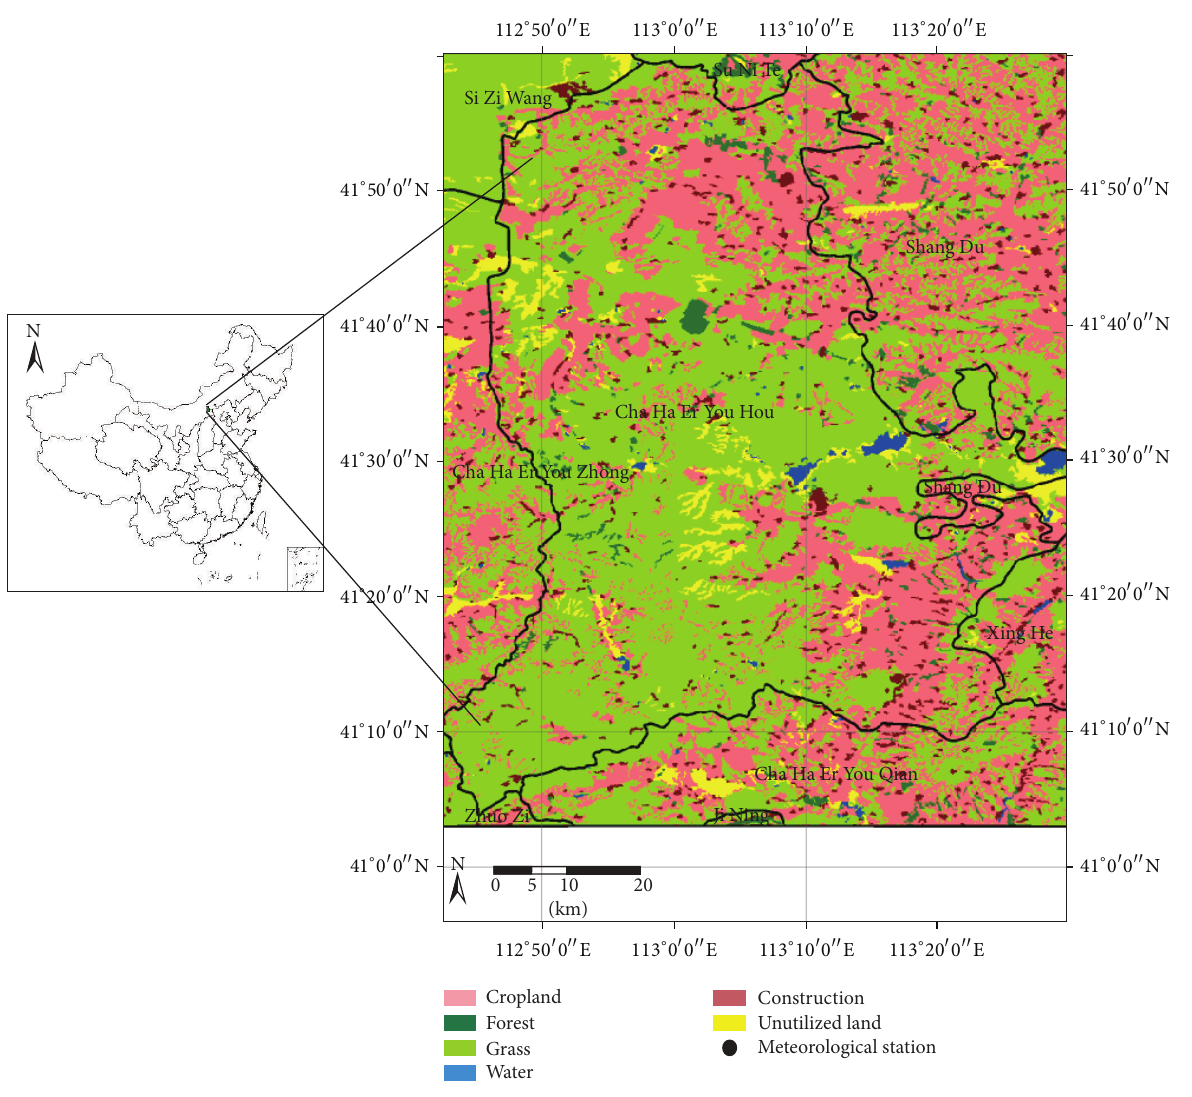
Figure 1: The location of study area.